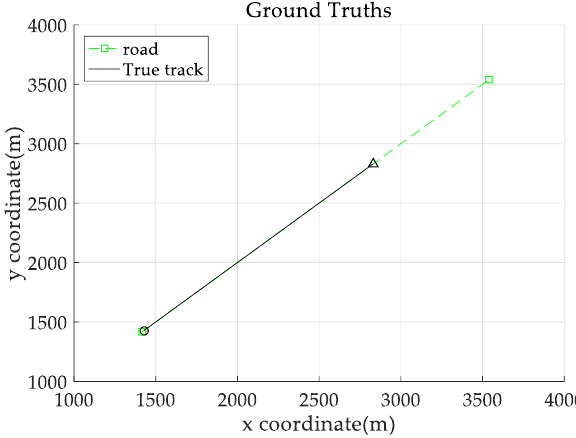
Figure 4. Road information (green dotted line) and target real trajectory (black solid line). “ ○ ” : location at which the target starts; “ △ ” : location at which the target stops.